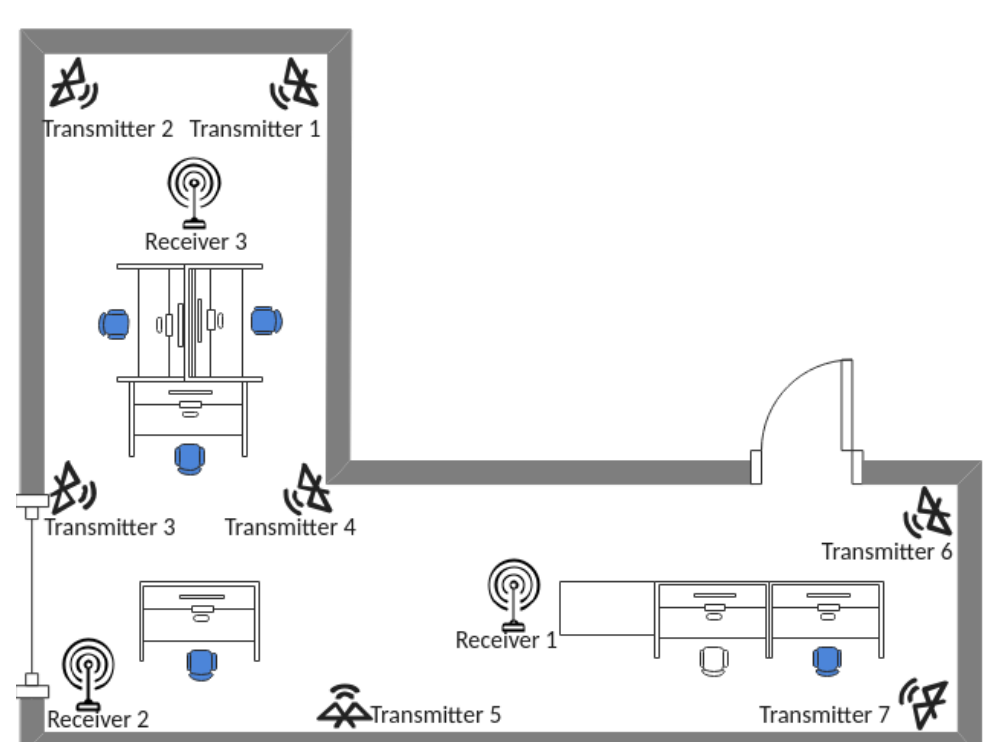
Figure 6. Arrangement of BLE devices in the laboratory testbed. The blue chair symbols represent the average positions of the occupants, i.e., the white chair was empty most of the time.